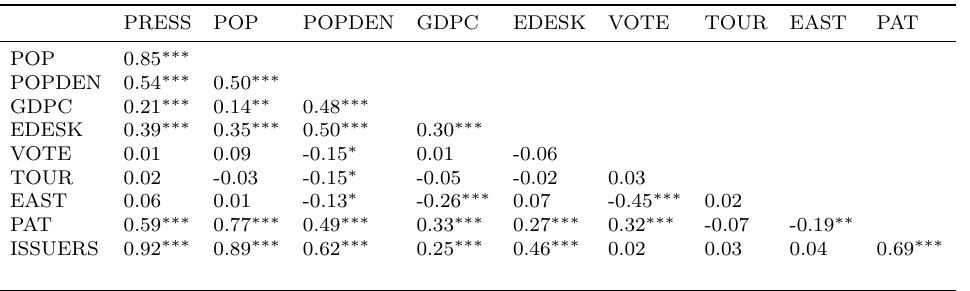
Table B.1: Correlation matrix